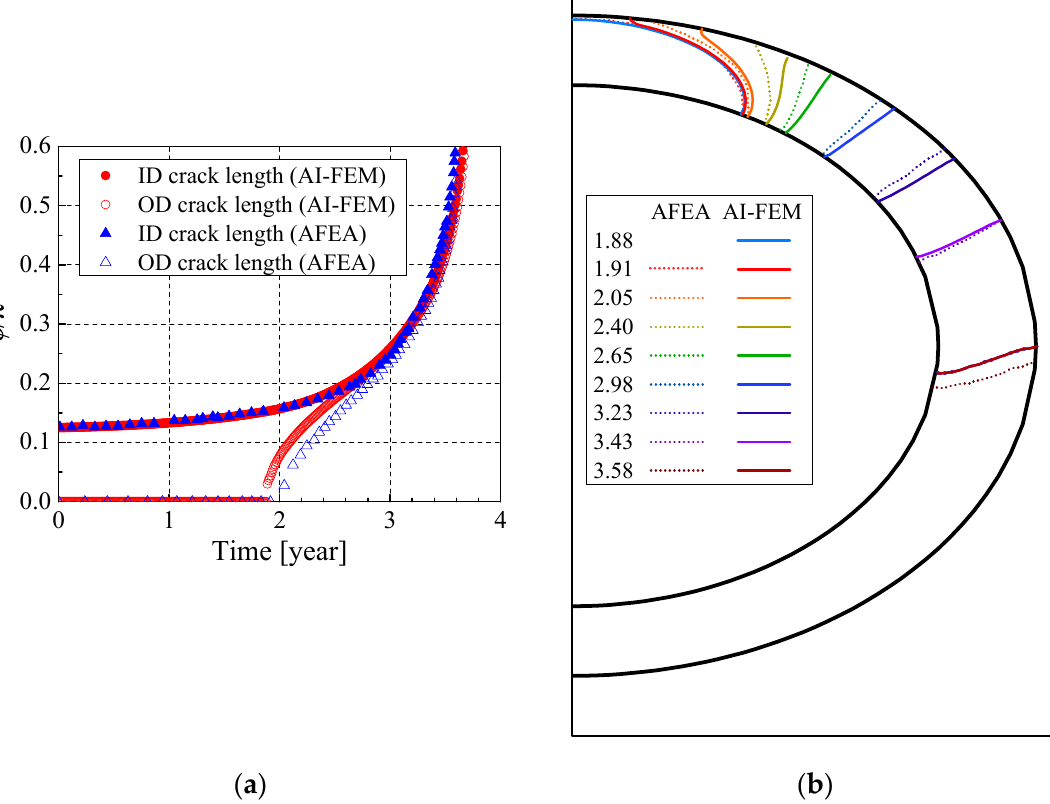
Figure 15. Comparison of SCC growth results according to time change: ( a ) Crack angles on inner and outer surfaces; ( b ) Overall crack shapes.